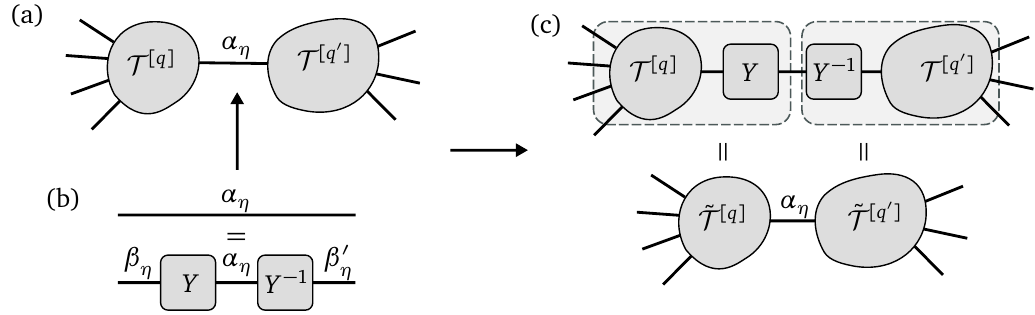
Figure 3: Gauge transformation: For a given tensor network (a), the link η between (cid:48) ] tensors T [ q ] and T [ q is replaced by a matrix Y and its inverse (b). Contracting Y and Y − 1 into their respective neighboring tensors (c) gives an alternative description of the tensor network without changing the physical content of the stored